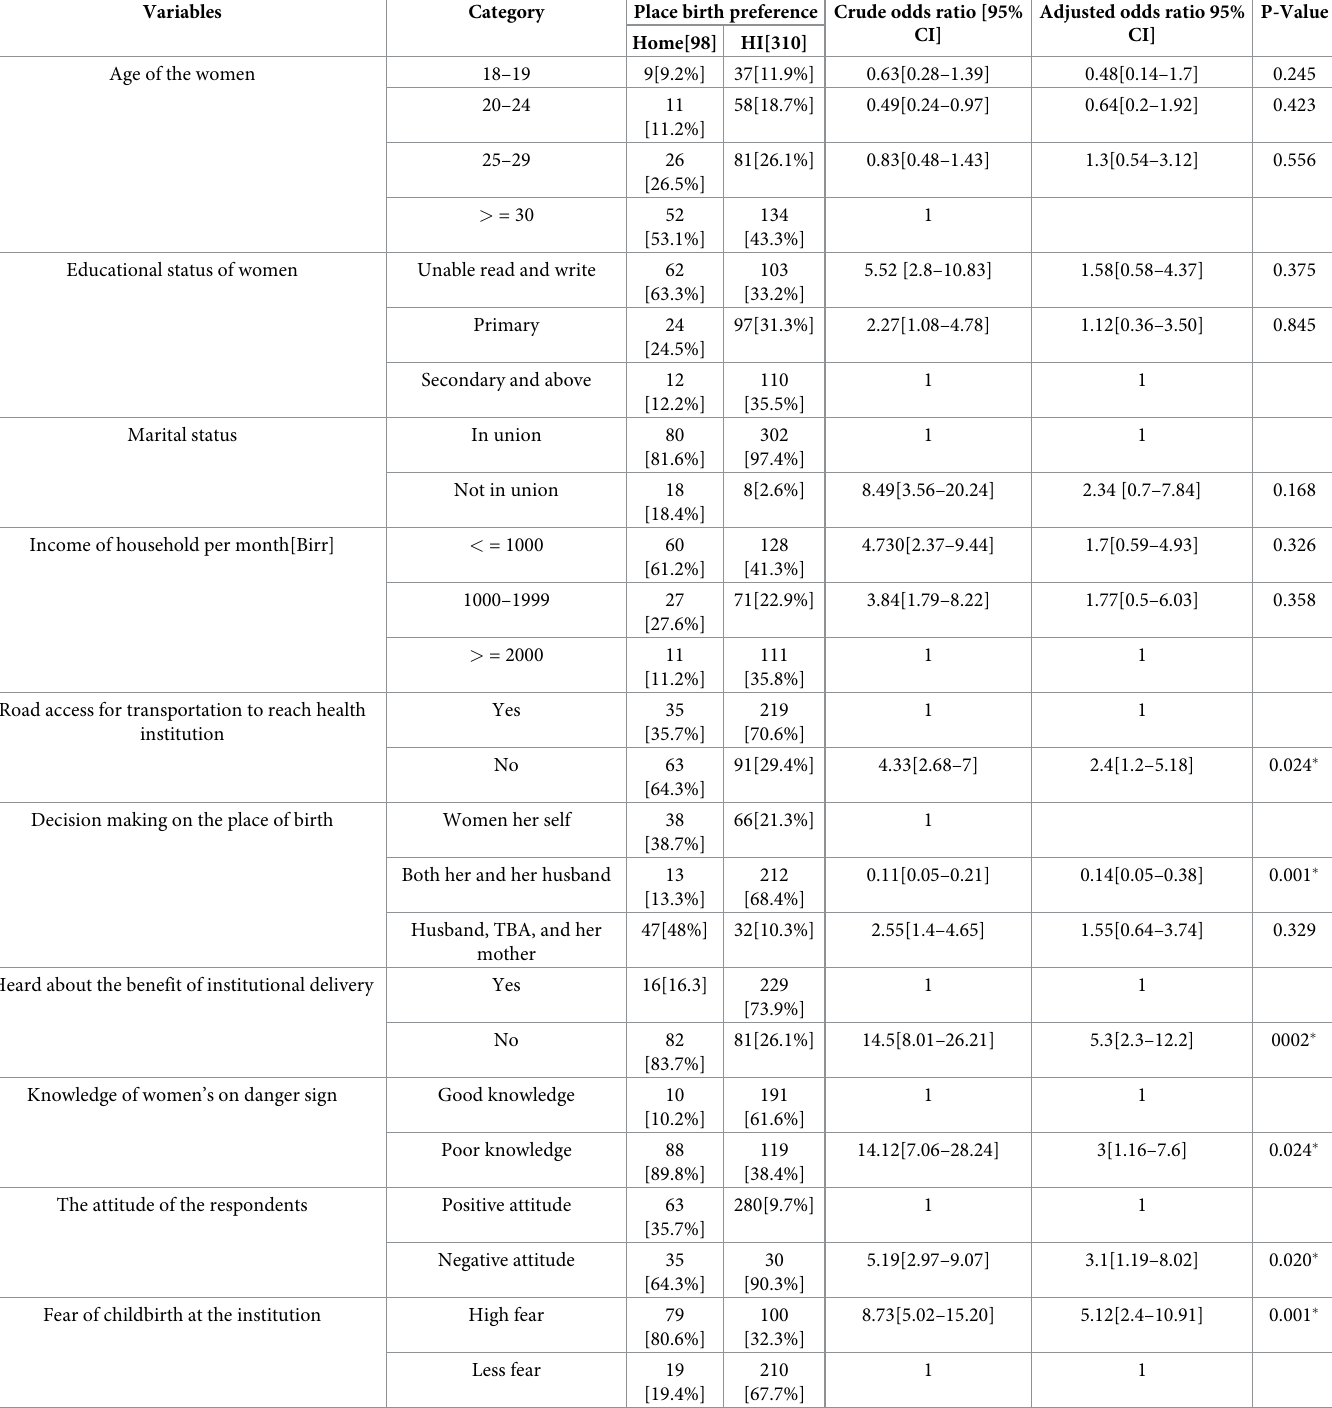
Table 4. Bi-variable and multivariable logistic regression analysis of the home birth preference among pregnant women in Arba Minch health demographic and surveillance site May